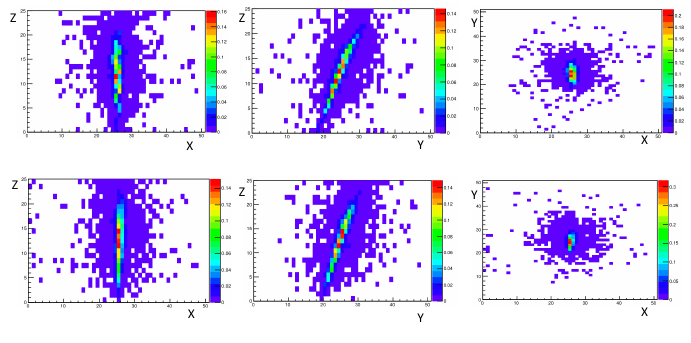
Figure 1. Example 2D energy shower sections on the xz , y z and x y planes for primary particle energy and incident angle equal to 142 . 52 GeV and 63 . 79 ◦ . Top: Geant4 electron. Bottom: GAN electron. The z axis lies along the detector depth and x , y are the transverse